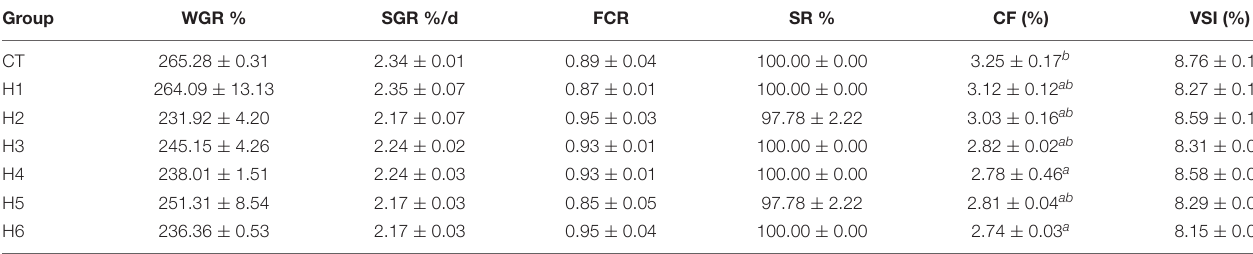
TABLE 4 | Effect of hydrolyzed fish protein powder on the growth and survival of juvenile pearl gentian hybrid grouper. Group WGR % SGR %/d FCR